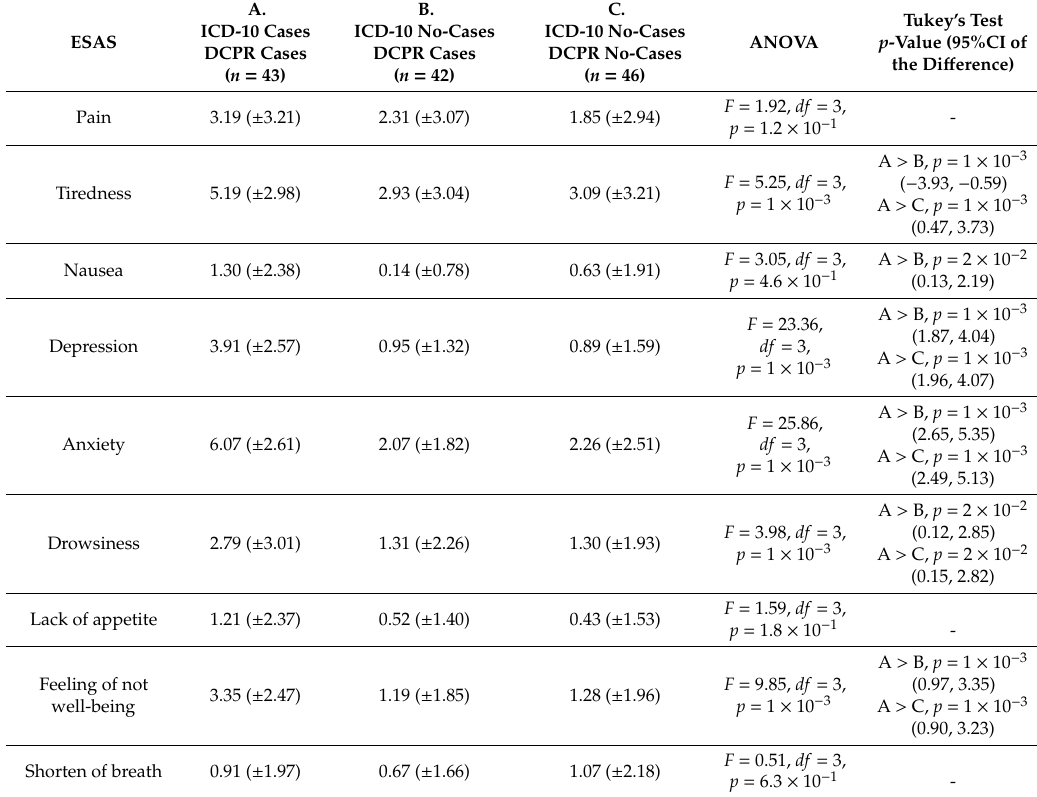
Table 4. Mean (SD) scores and significant di ff erences on the ESAS among ICD-10 and DCPR groups (cases and